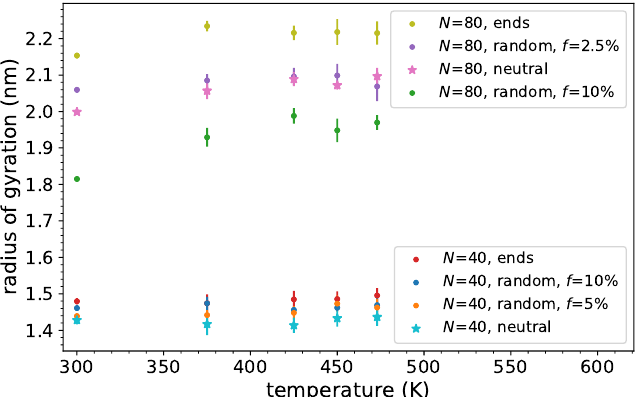
Figure 5. Radius of gyration R g versus temperature T of PDMS chains with N = 80 and N = 40 (neutral, end- and randomly grafted functionalized PDMS chains).